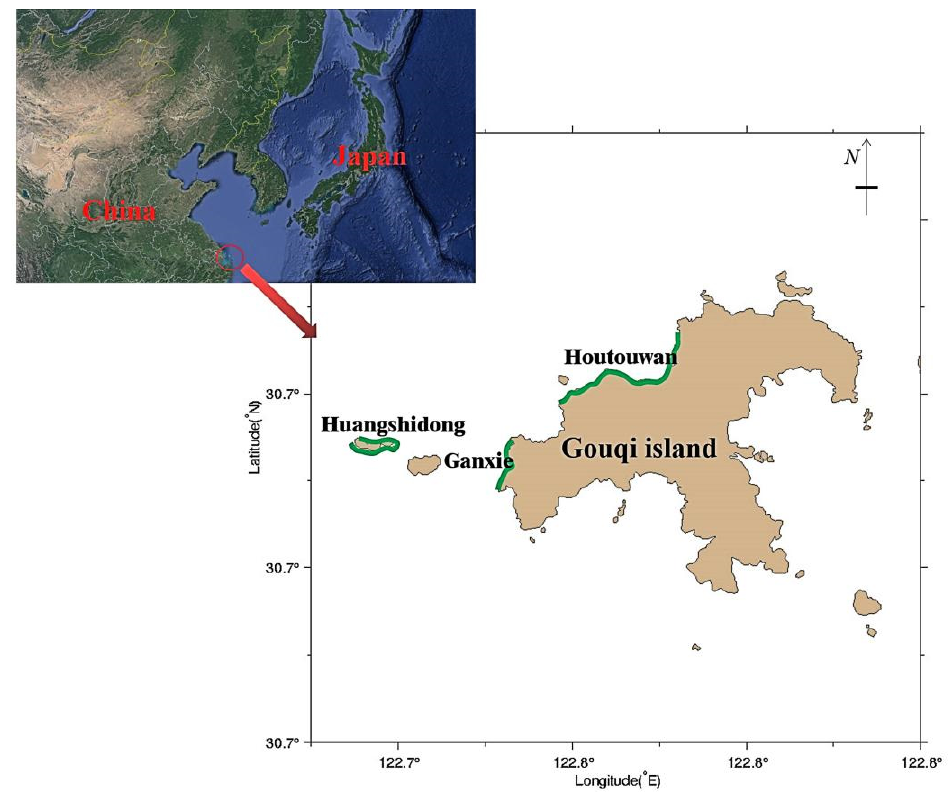
Figure 1. Map showing the sampled sites (Houtouwan, Ganxie, Huangshidong) of Sargassum horneri beds on Gouqi Island, Ma’an Archipelago, China. The green lines represent the cover area of Sargassum horneri beds.